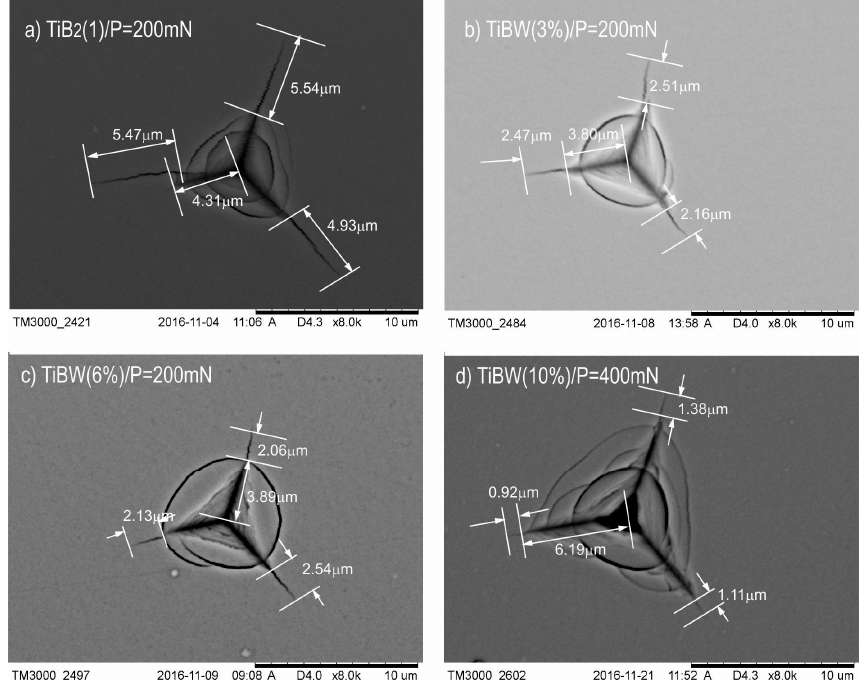
Figure 2. The SEM images of indentations for selected TiB 2 (1) and TiBW coatings after investigation with different values of applied loading force ( a ) TiB 2 ; P critical = 200 mN; ( b ) TiBW (3%); P critical = 200 mN, ( c ) TiBW (6%); P = 200 mN and ( d ) TiBW (10%); P critical = 400